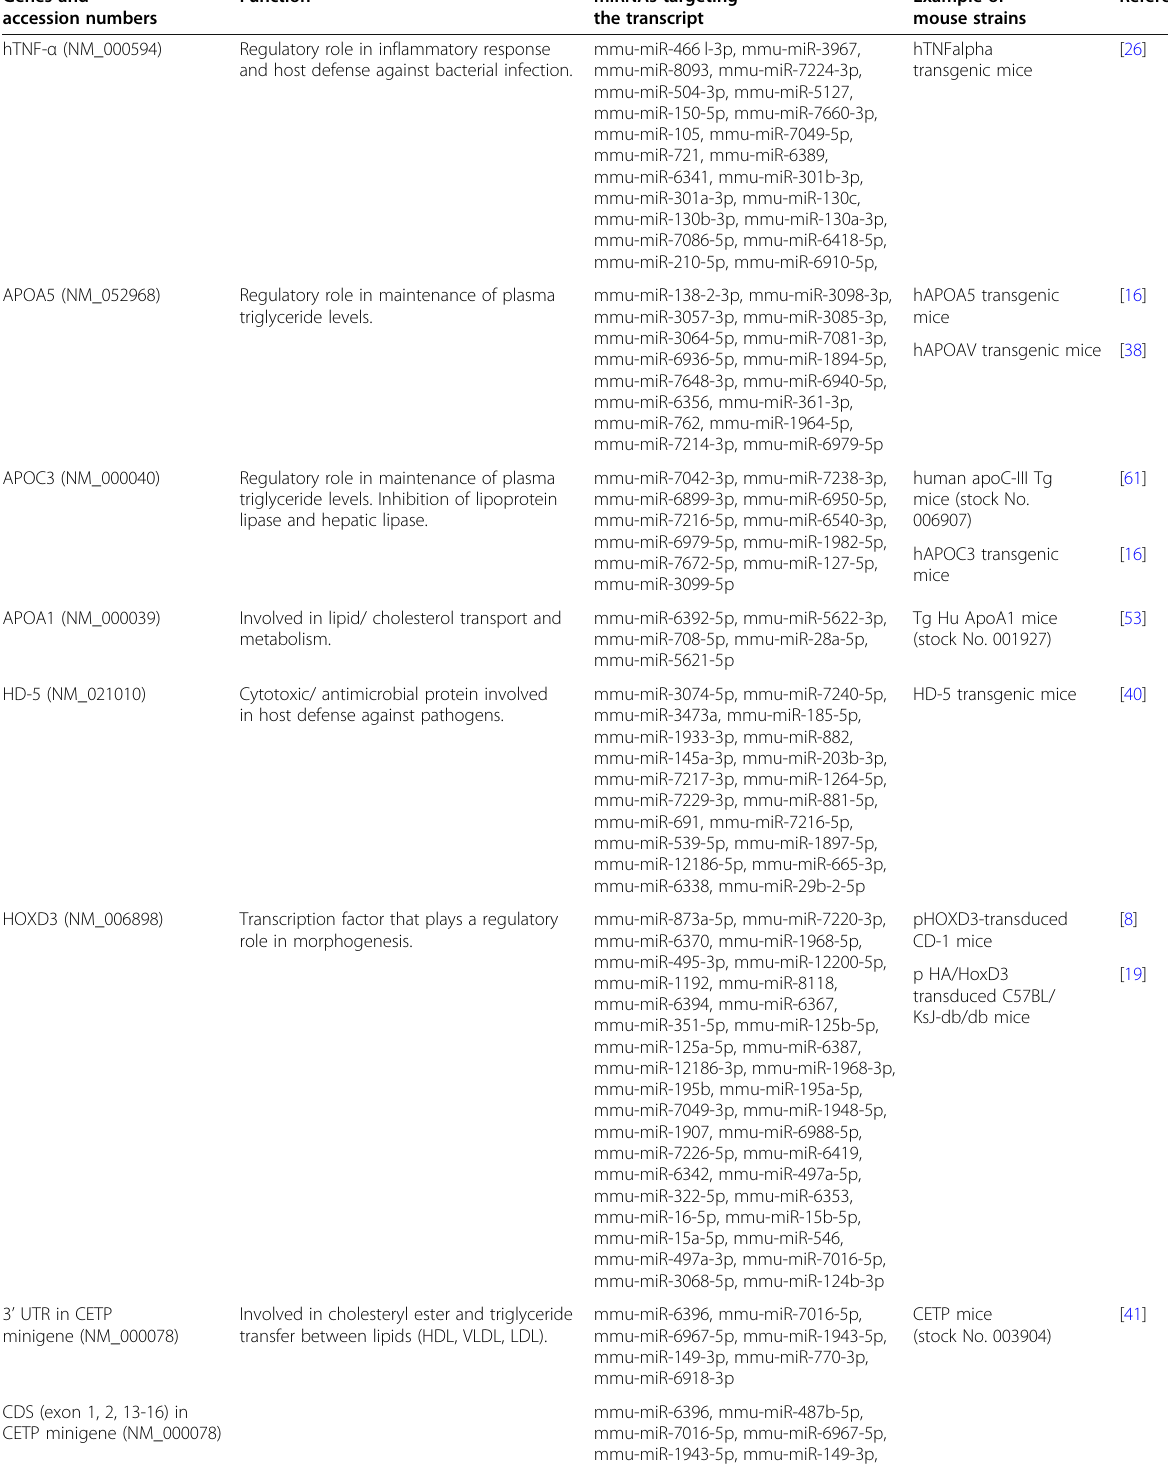
Table 2 Human genes expressed in transgenic mice are targeted by murine miRNAs in corresponding transgenic mice. Human genes expressed in transgenic mice become potential targets of Mus musculus miRNAs due to their foreign nature. This miRNA- target mRNA interaction may often lead to interference with their expression in mice. The potentially targeting miRNAs were retrieved from miRDB using their custom target prediction